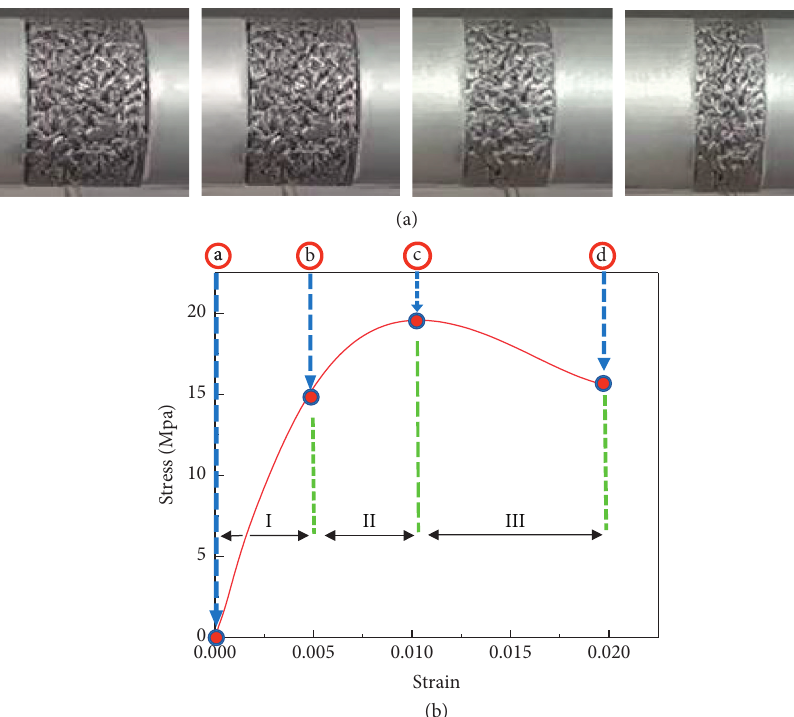
Figure 4: Typical stress-strain curve and the impact process of